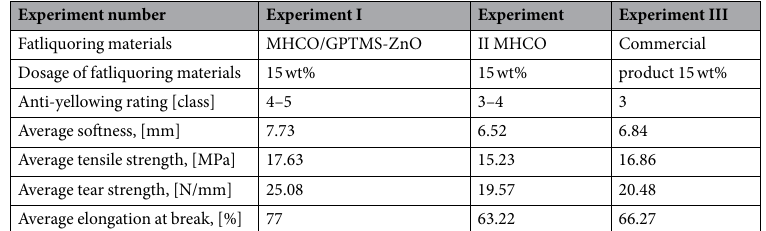
Table 1. Properties of leathers fatliquored with different fatliquoring materials. Experiment I-15 wt% MHCO/ GPTMS-ZnO, Experiment II-15 wt% MHCO, Experiment III-15 wt% commercial product.